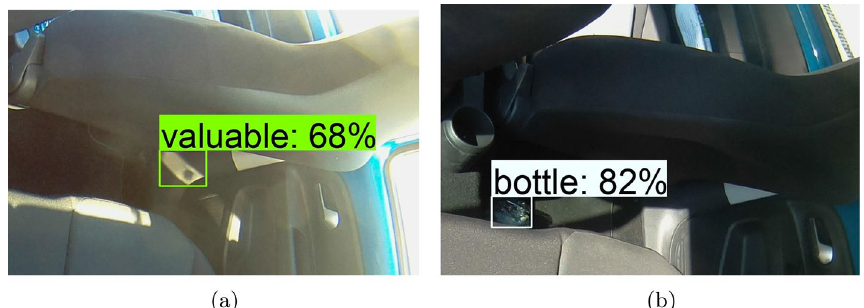
Fig. 24 Predicted test images of a false positive as a result of ( a ) a shadow and a misclassification in which